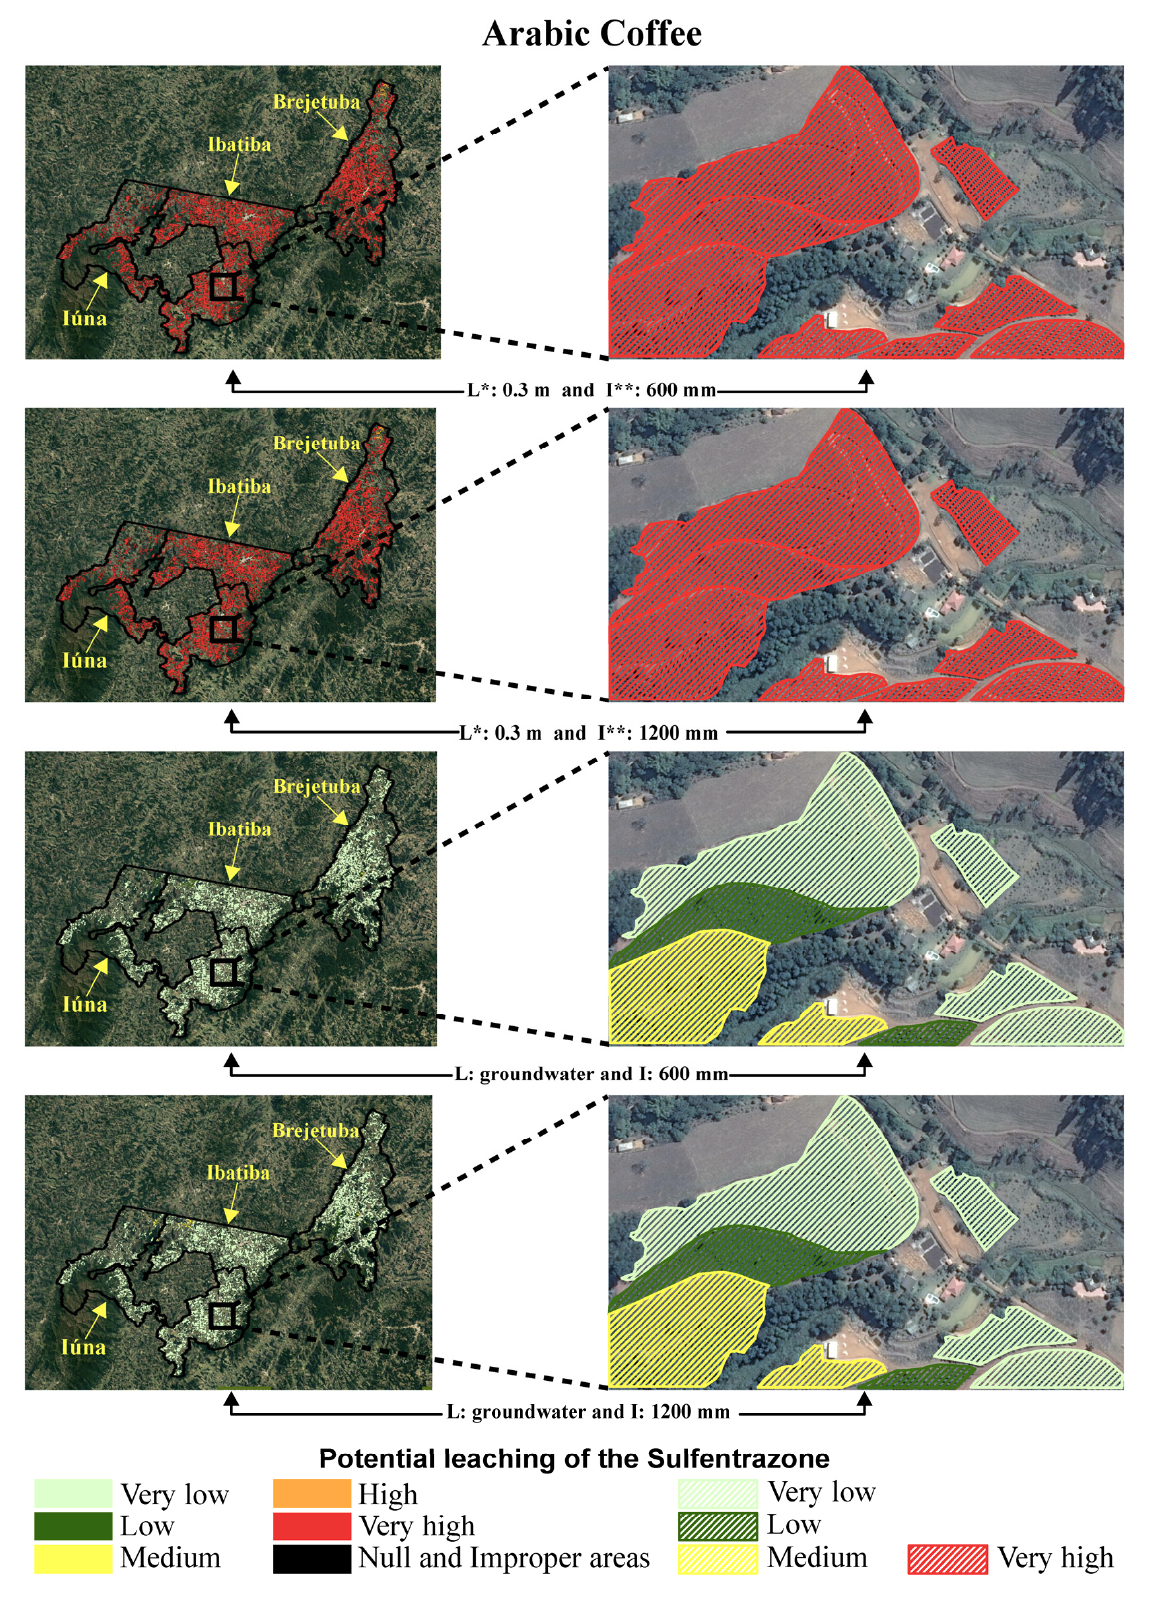
Figure 8. Attenuation Factor (AF) of active ingredient sulfentrazone evaluated for the extended study area cultivated with arabica coffee ( Coffea arabica L.) for the municipality of Iúna, ES, Brazil. * L: Groundwater depth and ** I: Irrigation.